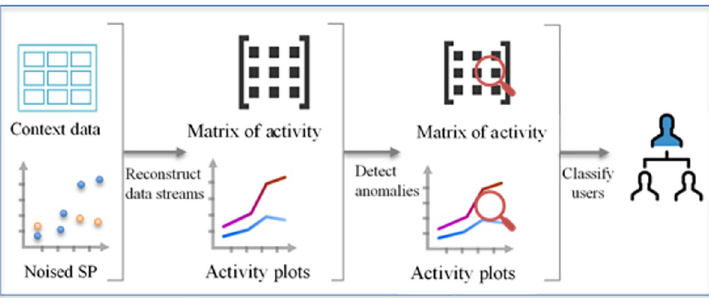
Fig 3. An overview of reconstructing the received data and classifying anomalous